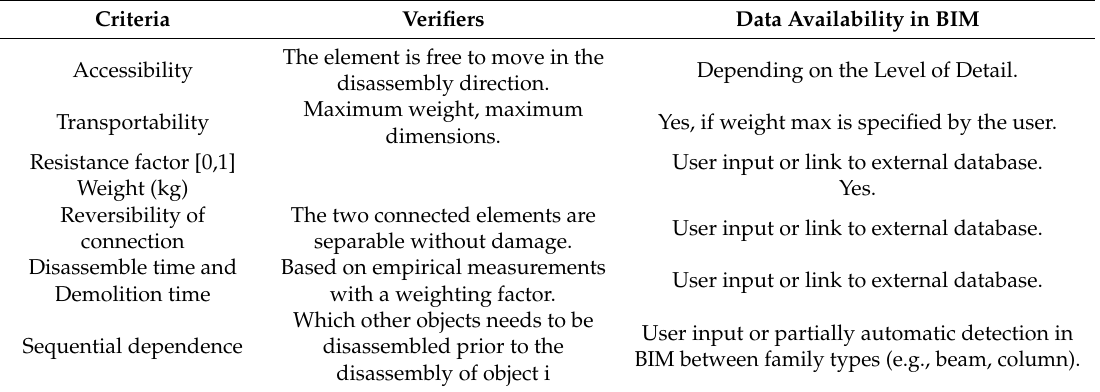
Table 2. Parameters involved in the Disassembly Network Analysis (DNA) method. The criteria influencing the potential recovery of a building were considered and translated into verifiers, which could be extracted from a BIM model automatically or provided with a manual input. Criteria Verifiers Data Availability in BIM The element is free to move in the Accessibility Depending on the Level of Detail. disassembly direction. Maximum weight, maximum